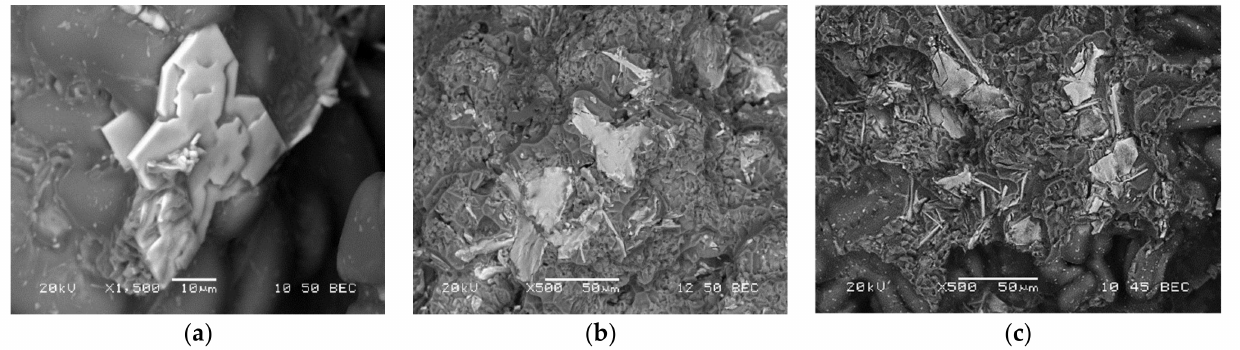
Figure 15. Fracture surface of M1S alloy in: ( a ) as cast, ( b ) SHT, and ( c ) T6 conditions. Figure 16a represents the fracture surface of M2S alloy (containing about 2 wt.%